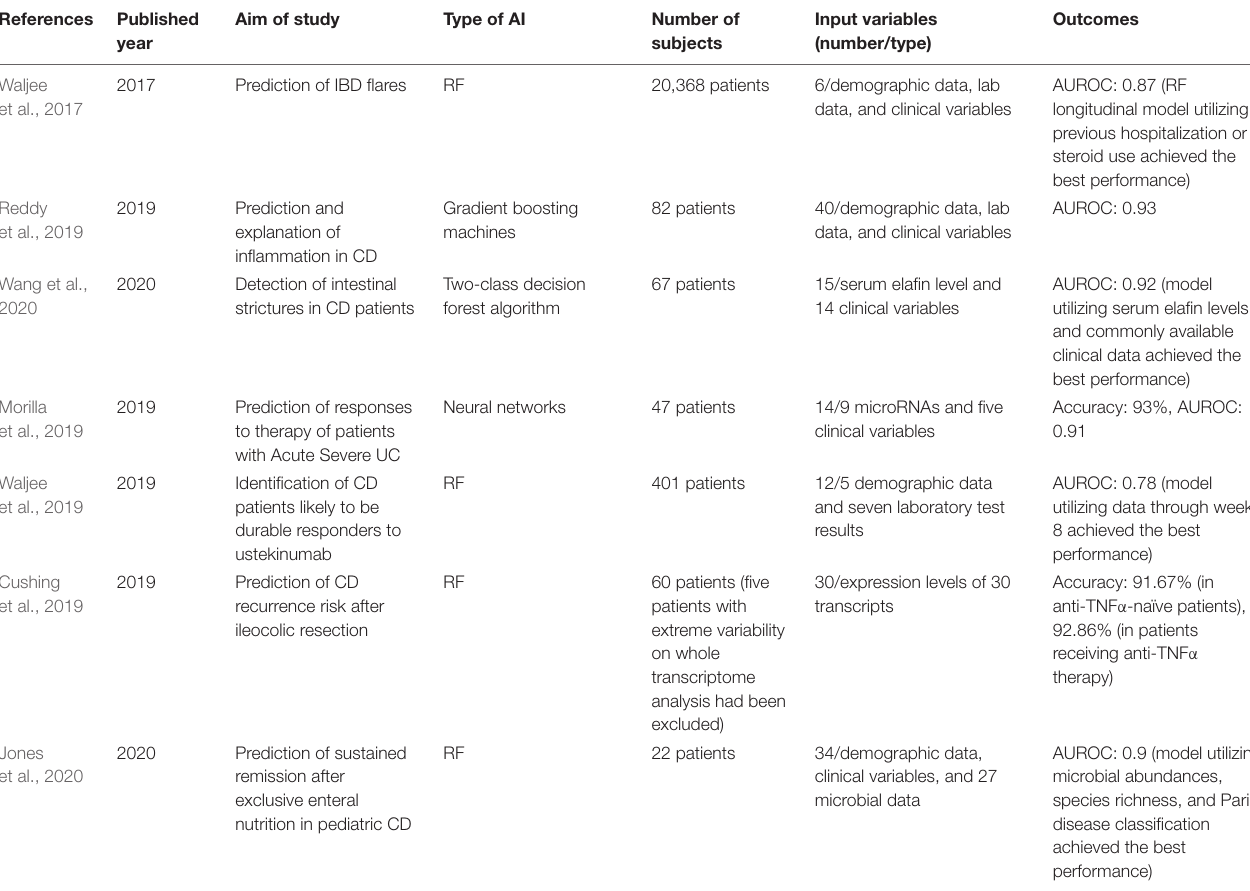
TABLE 3 | Summary of studies using artificial intelligence in IBD